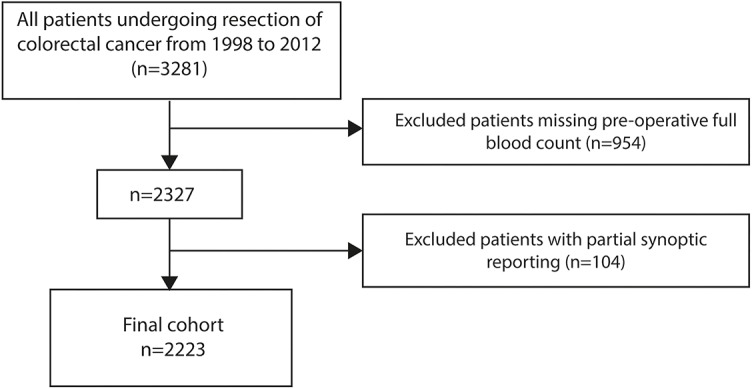
Flow chart of patient selection based on inclusion and exclusion criteria.